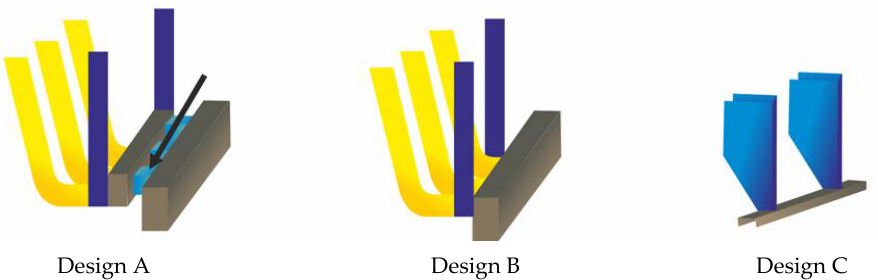
Figure 5. Schematic view of the RUPD versions used for tests.